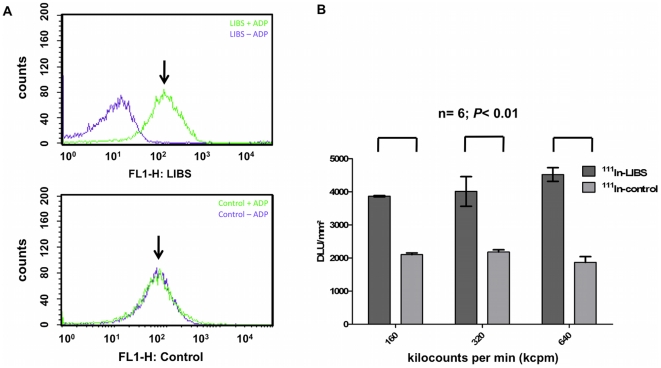

In vitro analysis of specific 111In-LIBS
binding to activated platelets.(A) Flow cytometric analysis of platelets, non-activated (-ADP) and
activated (+ADP), after incubation with DTPA-labeled LIBS or
control as indicated. After incubation with DTPA-labeled LIBS, activated
platelets showed a clear shift indicating specific target binding
(above, ↓). This was not seen after incubation on non-activated
platelets or application of the control antibody (below, ↓) (B)
Autoradiographic imaging of incubated 111In-LIBS on activated
platelets compared to 111In-control. Ligand uptake is
depicted in digital light units/mm2 (DLU, y-axis) after
incubation with increasing antibody doses, as measured by radioactivity
(in kilocounts per minute (kcpm); in parenthesis the protein mass used):
160 kcpm (29 ng), 320 kcpm (58 ng) and 640 kcpm (116 ng), respectively
(x-axis). A significant increase in ligand uptake is registered after
incubation with 111In-LIBS (left column) compared to
111In-Control (right column) at every activity level
(n = 6; P<0.05). Given are mean
values ± one standard deviation.